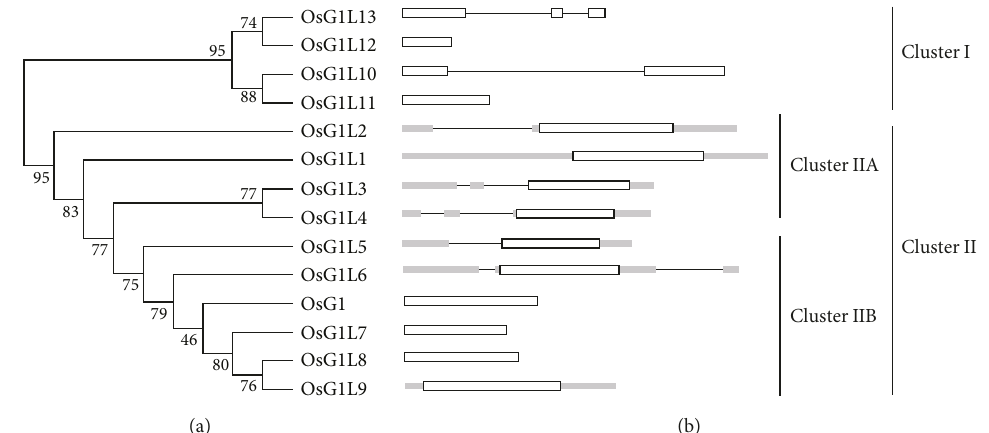
Figure 2: Phylogenetic relationships of the OsG1/G1L proteins and the exon-intron organizations of the corresponding genes. (a) The unrooted tree was generated with the default parameters and the “ aLRT ” statistical test model using PhyML. (b) Using the sequences from the TIGR locus in Table S4, the exons, introns, and UTRs are represented by white boxes, lines, and black boxes, respectively.